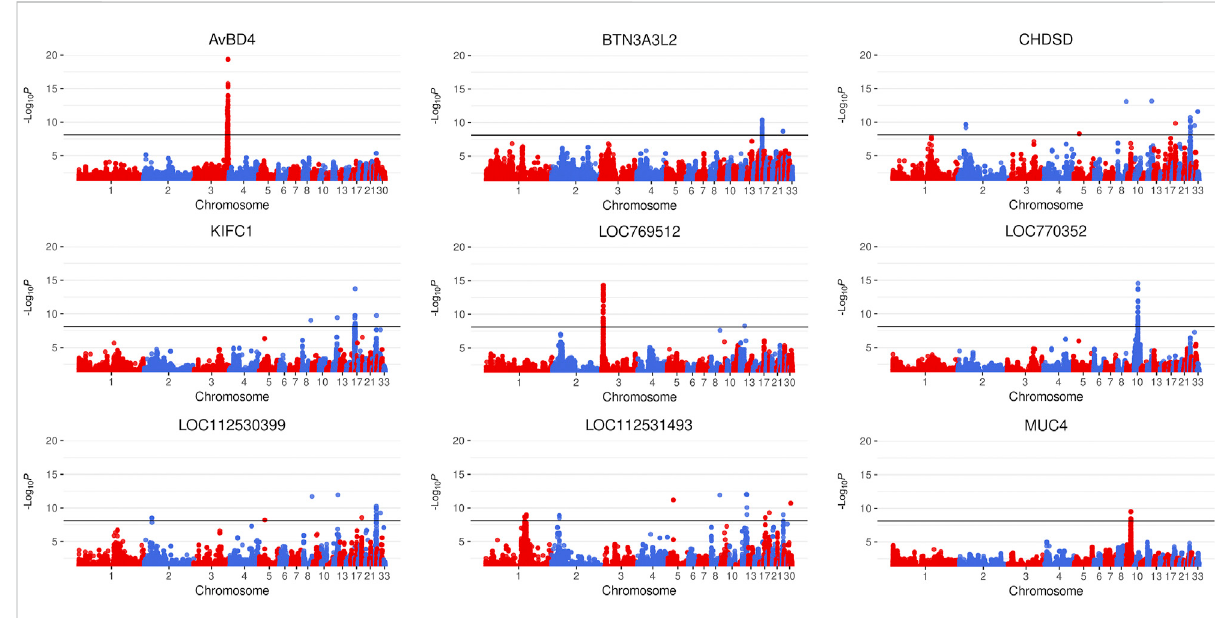
FIGURE 1 Manhattan plots of expression genome wide association studies (eGWAS) that yielded highly signi fi cant QTL, conducted on genes differentially expressed between high and low feather pecking hens (Bonferroni threshold ( number of variants